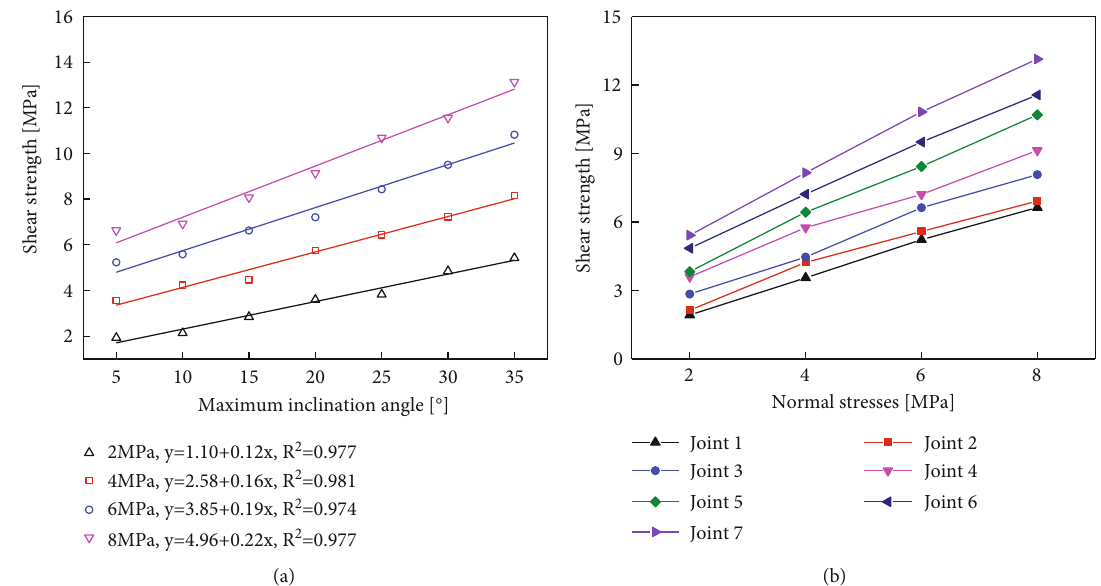
Figure 7: The variation curve of shear strength with the maximum inclination angle and normal stresses: (a) maximum inclination angle; (b) normal stress.